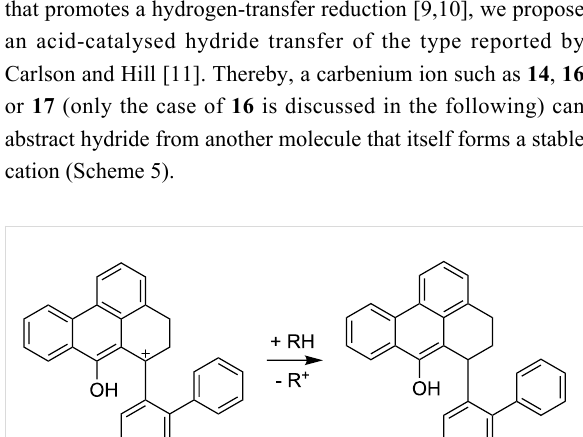
Table 1: Gas phase electronic energies/enthalpies for intermediates generated along the proposed reaction pathway. All values are given in kcal mol −1